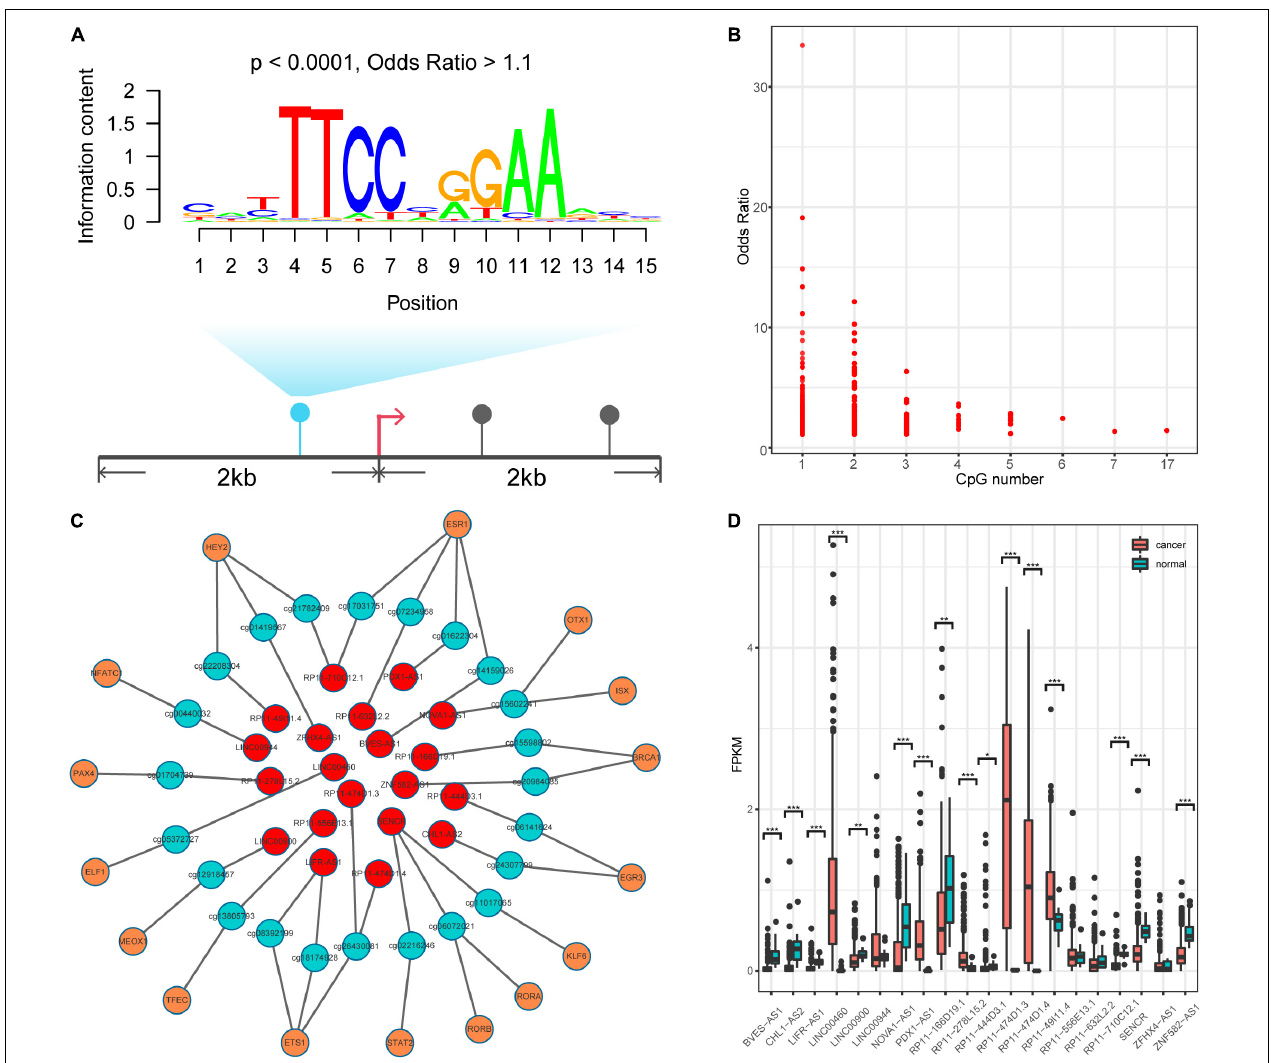
FIGURE 3 | Identification TF-methylation-lncRNA relationships. (A) An example for illustrating the TF motif occurrence in lncQTM. (B) Lower OR value and the related CpG number. (C) An unweighted network of TF-methylation-lncRNA relationships, including 59 nodes (16 TFs, 23 methylation sites, and 20 lncRNAs), 49 edges (25 edges between TFs and DNA methylation sites, 24 edges between DNA methylation sites and lncRNAs). Red nodes represent lncRNAs, green nodes represent methylation sites, and orange nodes represent TFs. (D) LncRNA expression level for colon cancer and normal samples (Wilcoxon rank-sum test, two-tailed). *Denote p < 0.05, **denote p < 0.01, ***denote p <